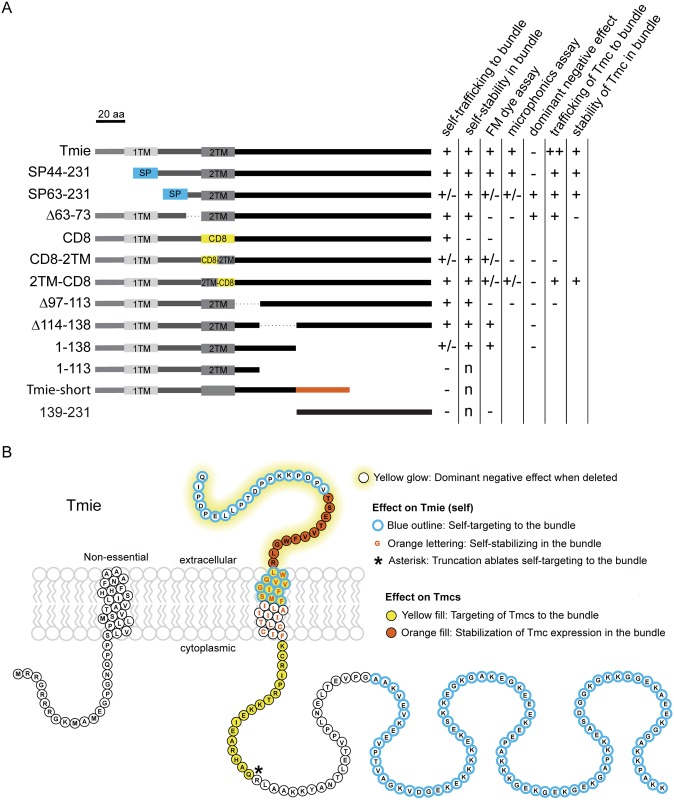
Summary of experimental results for tmie constructs and model of discrete functional domains of Tmie.(A) Symbols as follows: enhanced above wild type (++), comparable to wild type (+), partially reduced (+/-), severely reduced or absent (-), and not applicable (n). For dominant negative effect, the effect is present (+) or absent (-). Blank spaces were determined for reasons discussed in the text. Refer to Fig 5A for details on constructs. (B) A model of the protein sequence of zebrafish Tmie. Amino acids 1–43 are separated due to suspected cleavage as a signal peptide. Although shown as a TM domain, it is unclear whether the first hydrophobic region forms a helix. Note that the extracellular region (yellow glow) was never deleted in its entirety; SP63-231 deleted QIPDPELLPTDPPKKPDPV, and Δ63–73 deleted TSETVVFWGLR. Also note that the TM domain (orange lettering) only had an effect on the stability of Tmie when the entire helix was substituted.